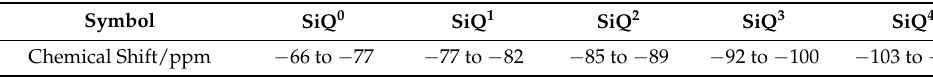
Figure 13. The 29 Si NMR spectra of CBRM-cement ( a ) and Tailings-cement ( b ). Table 8. The SiQ n and RBO of CBRM-cement and Tailings-cement. Table 7. Chemical shift range of the structure unit.